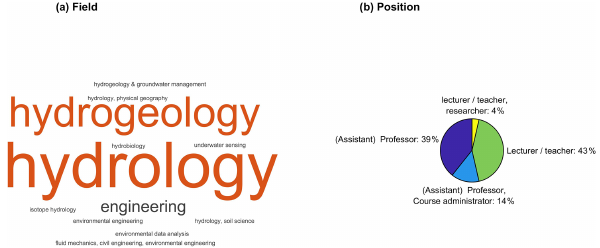
Figure 2. These respondents indicated in which part of water sci- ence they work in panel (a) , represented qualitatively as a word cloud. The larger the font, the more respondents indicated feeling connected to and working in it (multiple answers were possible). The different roles (levels) in water education indicated by the re- spondents given as a percentage (b) .